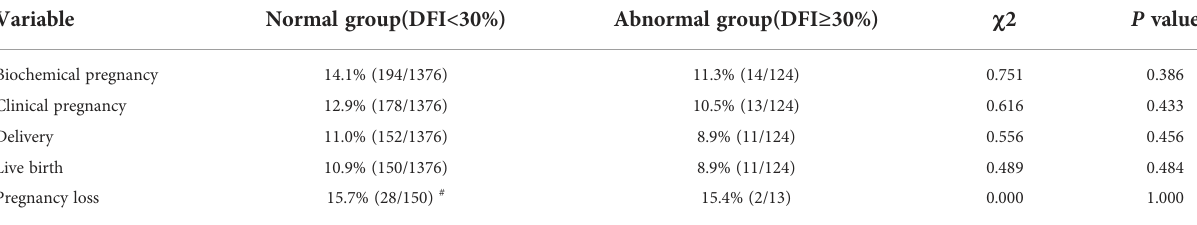
TABLE 3 Comparison of clinical outcomes between the normal and abnormal sperm DFI groups in IUI cycles.